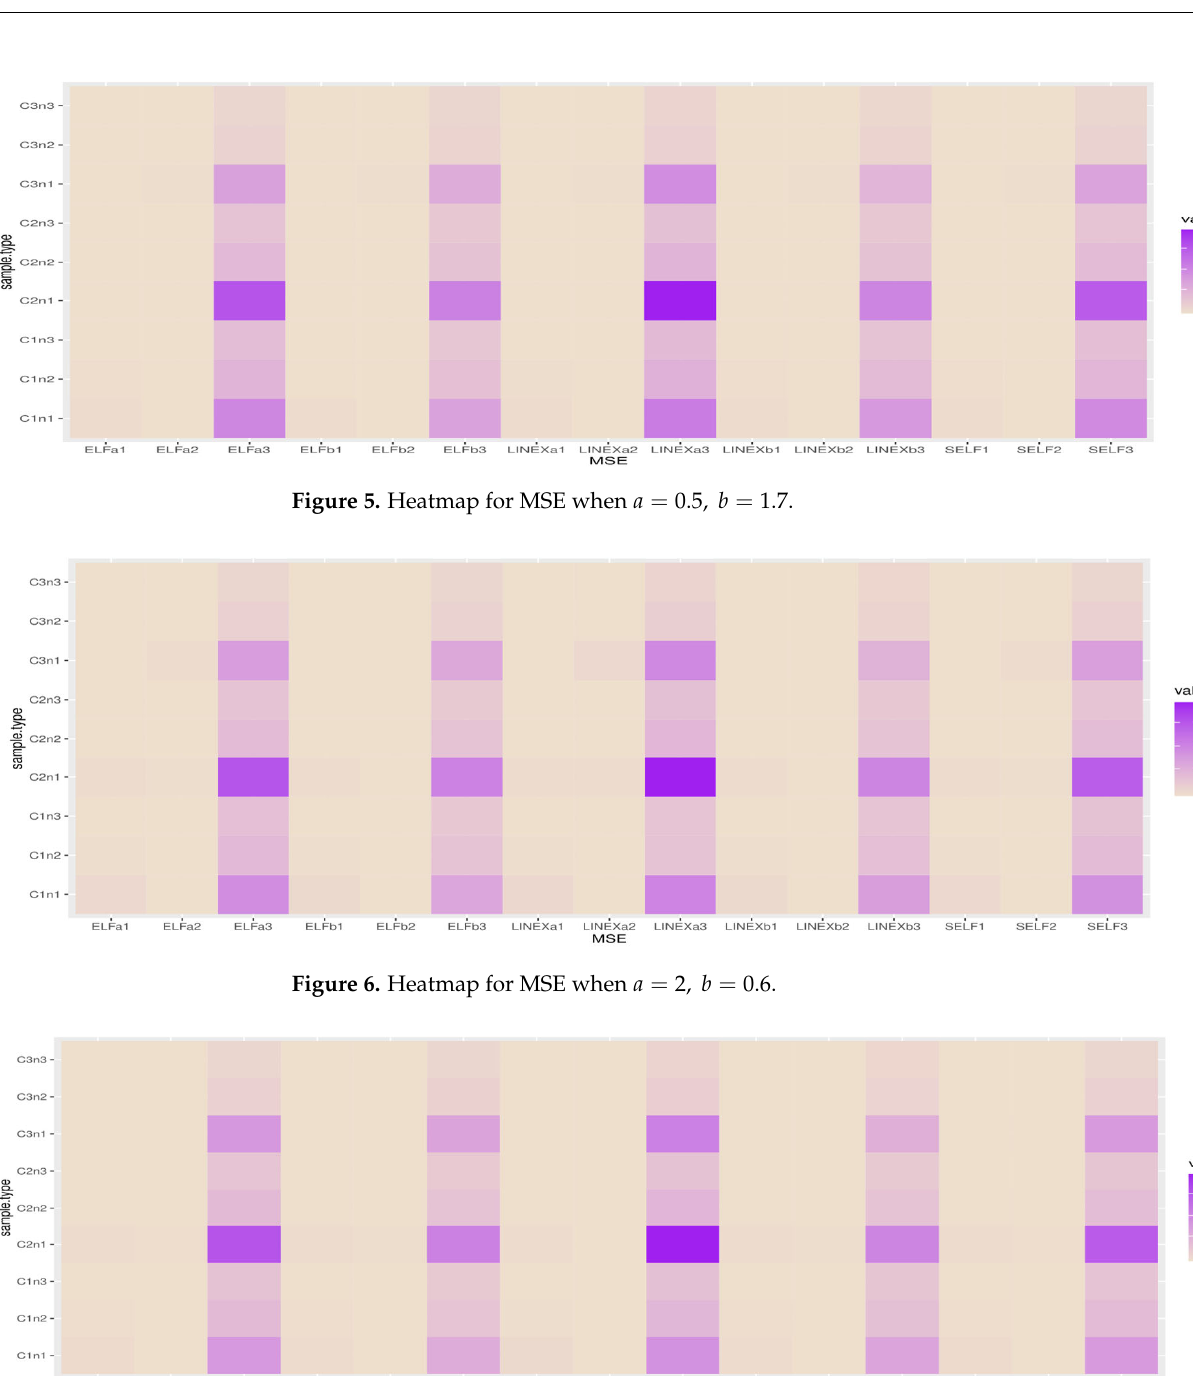
Figure 4. Heatmap for MSE when 𝑎 (cid:3404) 0.5, 𝑏 (cid:3404) 0.6 .